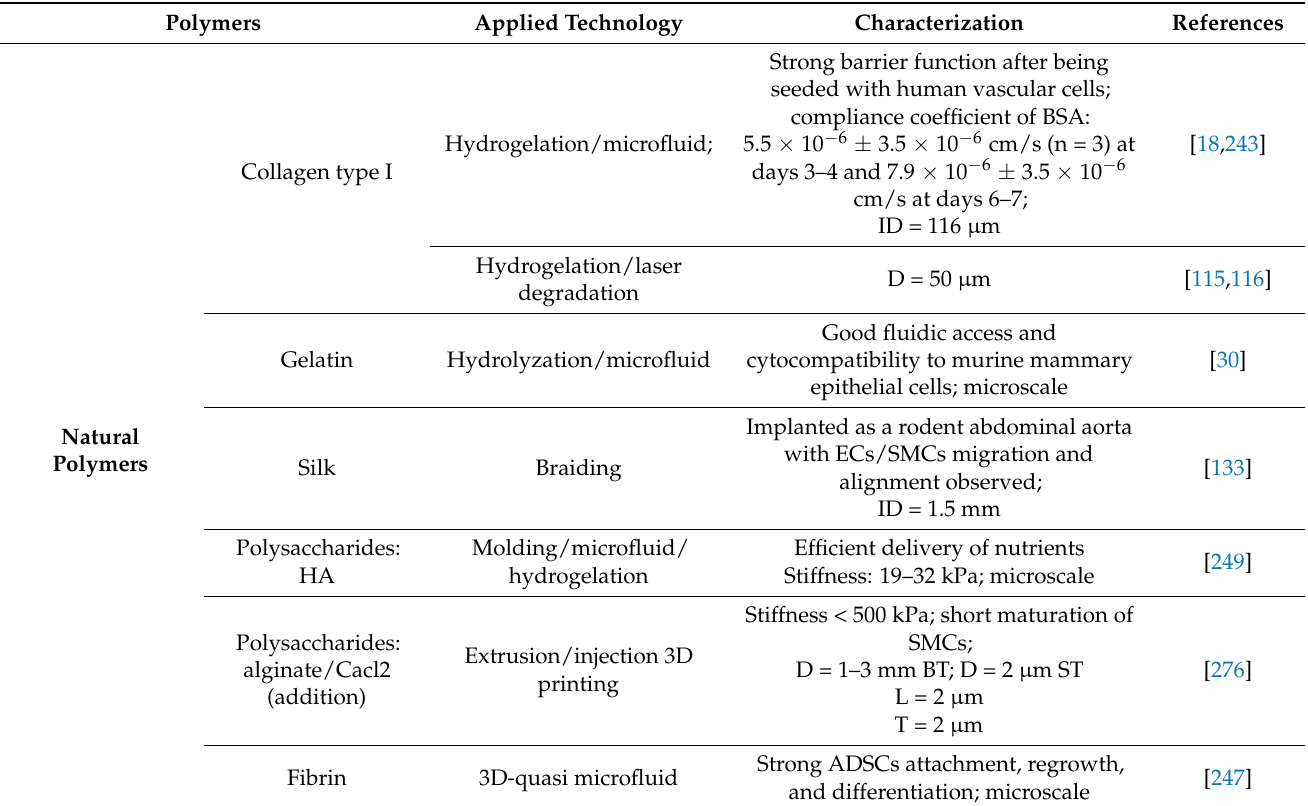
Table 1. Polymer-Based TEVGs and